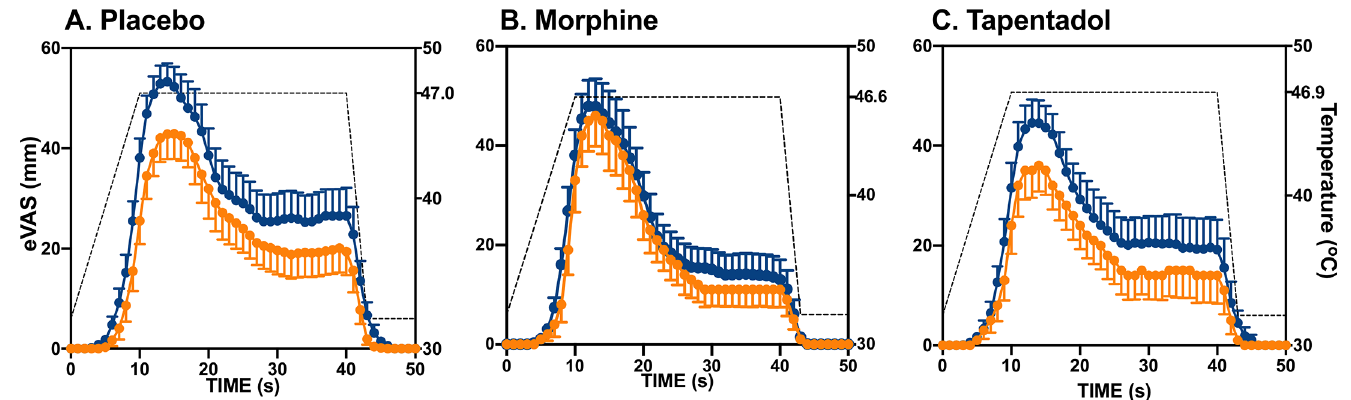
Fig 3. Mean eVAS responses following treatment with placebo (A), oral morphine immediate release 40 mg (B) and oral tapentadol immediate release 100 mg (C) at 60 – 90 min after drug intake. The blue dots are the responses to the test stimulus without conditioning stimulus, the orange dots the responses to the test stimulus with conditioning stimulus. The broken line is the mean temperature of the test stimulus. Values are ± SEM.